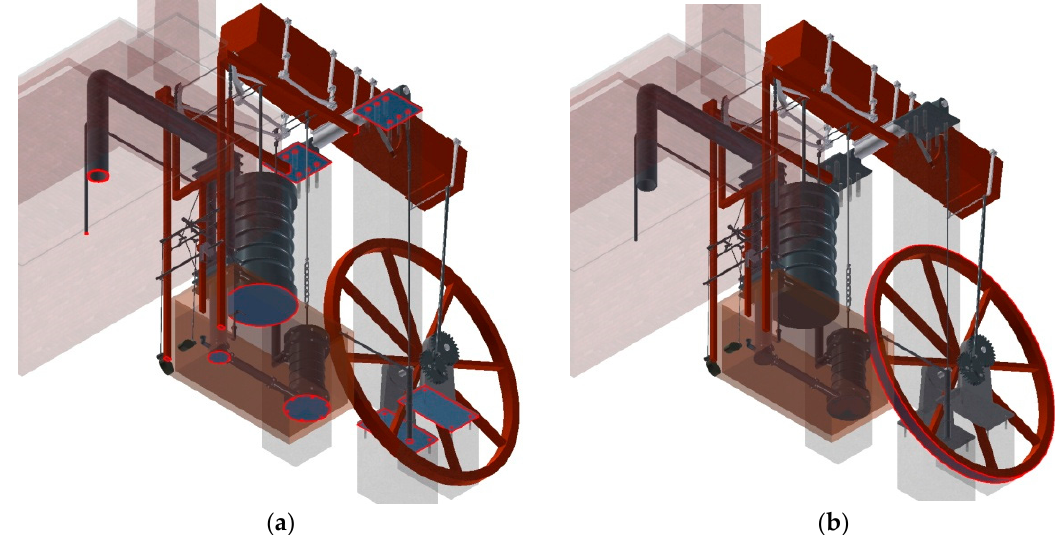
Figure 5. Embedded supports: ( a ) fixed elements ( b ) inertia flywheel defined as a built-in element to simulate stop situation.